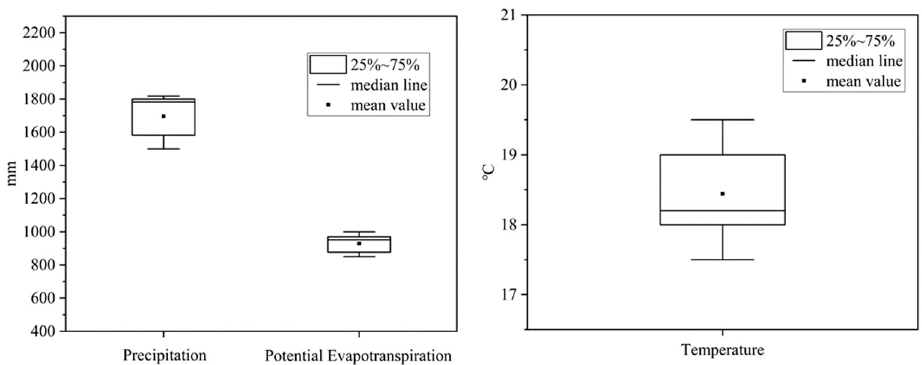
Figure 2. Ranges for annual precipitation, annual average temperature, and potential evapotranspiration.